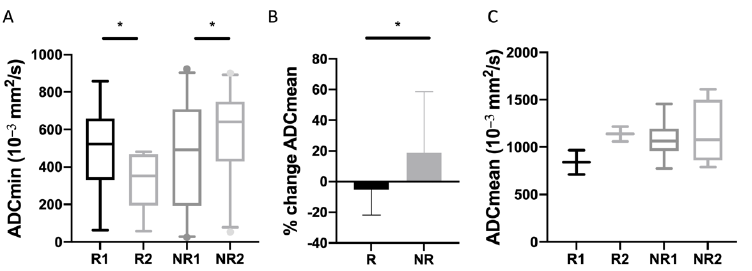
Figure 2. Analysis of ADC changes in NELMs and pNETs. ( A ) ADCmin of NELMs on baseline and first FU imaging. ( B ) Percentual changes of ADCmean of NELMs. ( C ) ADCmean of pNETs on baseline and first FU imaging. Asterisks indicate statistical significance (* p ≤ 0.05).